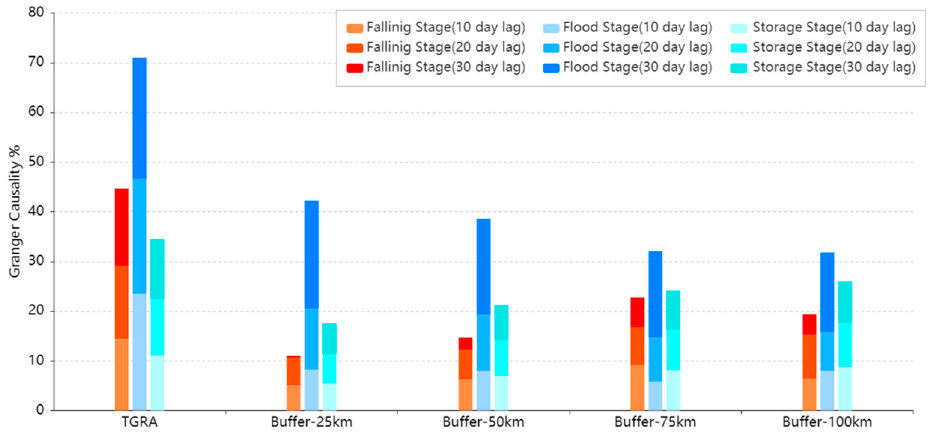
Figure 6. The spatial–temporal causality for the vegetation dynamics due to the water level variations across the TGRA.